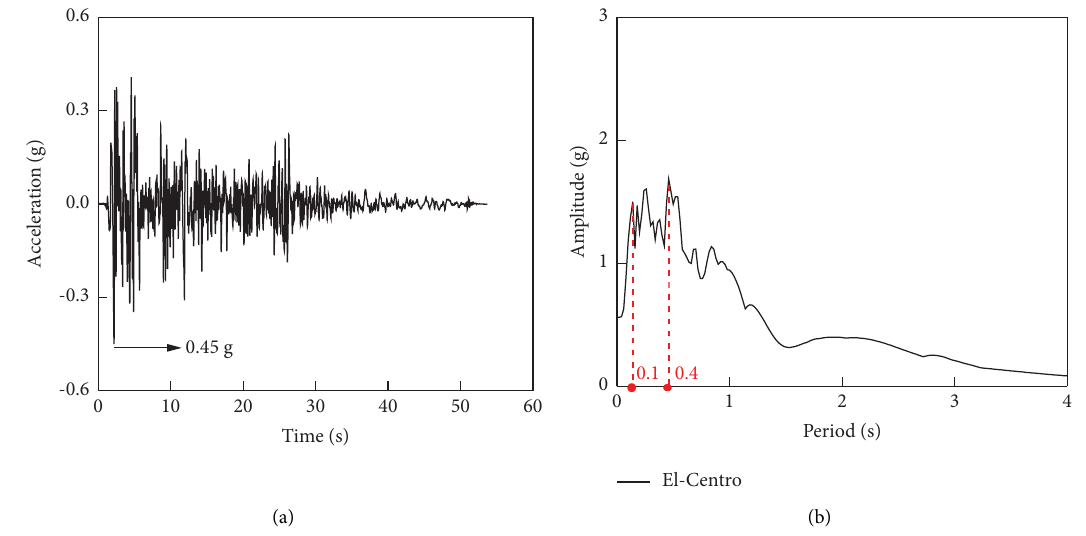
Figure 10: El-cento earthquake wave showing (a) acceleration time history and (b) the acceleration spectrum. Table 4: Test scenarios in